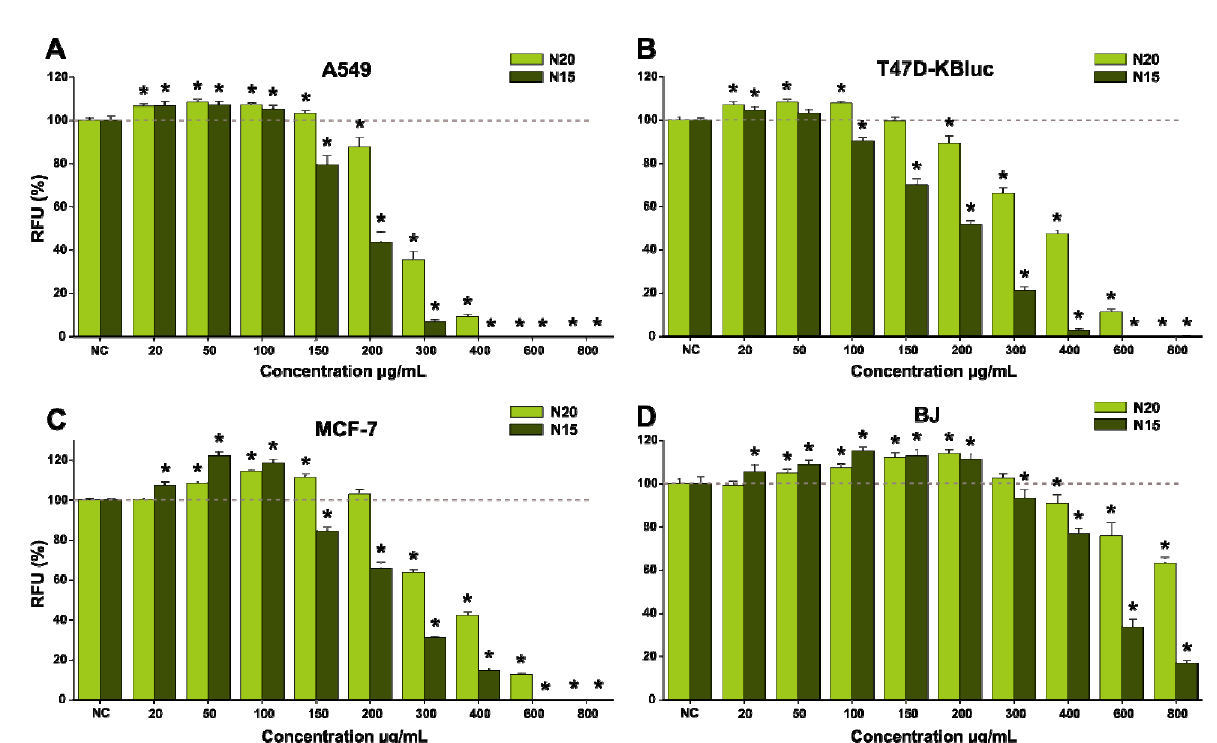
Figure 9. Effects of the Juglans sp. extracts (N20, N15) on the cancerous cell lines A549 ( A ), T47D-KBluc ( B ) and MCF-7 ( C ) and on normal BJ cells’ ( D ) viability after 48 h exposure. The results are presented as relative mean values ± standard deviations, where the negative control (NC) is 100%. Significant differences in comparison with NC (ANOVA + Dunnett’s; p < 0.05) are marked with *. Table 8. Calculated IC 50 (µg extract/mL) values after exposure of A549, T47D-kbluc, MCF-7 and human normal foreskin fibroblasts (BJ) to the two extracts for 24 h and 48 h.